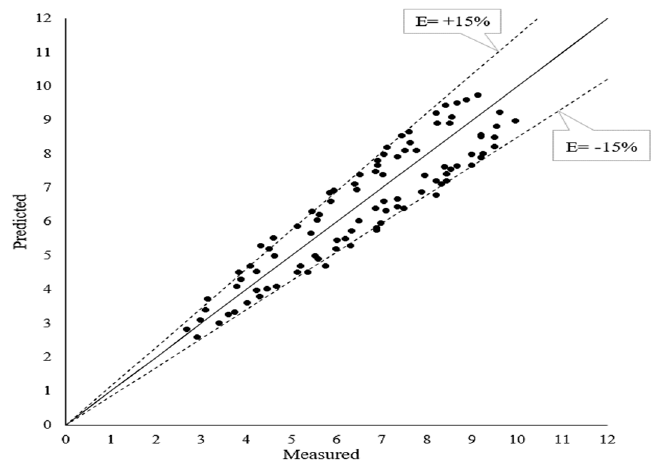
Figure 10. Comparison of the measured and predicted values of the mean velocities (cm/s).